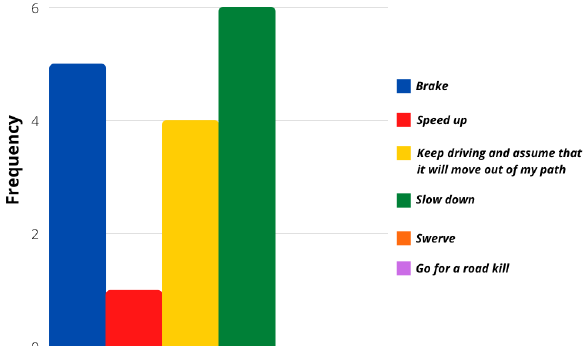
Figure 9. Question 56 results.